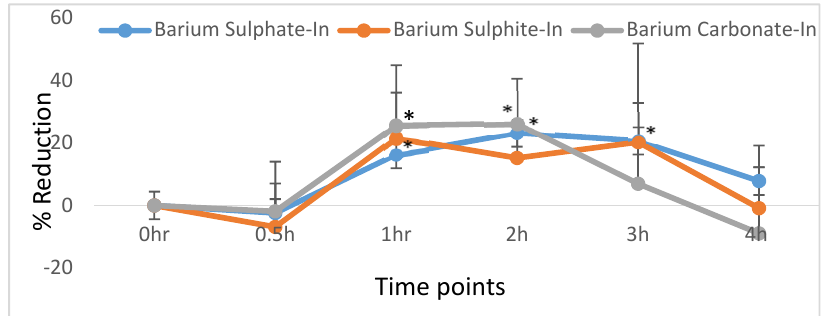
Figure 14. Oral administration of insulin-loaded Ba salt particles. Animals were fed with Ba salt particles with loaded insulin (100 IU/kg). Each control and treatment groups have 3 animals per group. The baseline blood glucose level was read before the treatment. % of reduction of blood glucose level at different time points. The blood glucose level at “0” h is the baseline blood glucose reading taken right before oral treatment with insulin-loaded particles. The mean value of (± standard deviation) was plotted for BaSO 4 , BaSO 3 , and BaCO 3 loaded with Insulin aspart (100 IU/kg). A significant % reduction was observed for BaSO 4 loaded insulin (1–3 h) and BaCO 3 loaded insulin (1– 2 h) ( p < 0.05) .